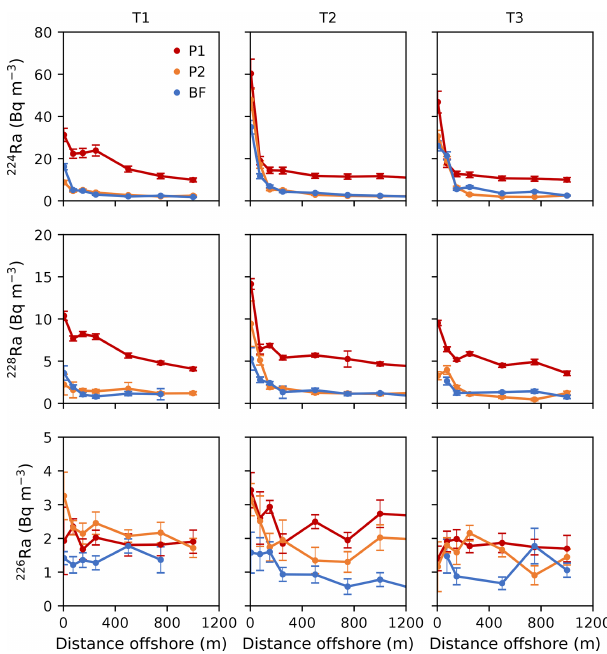
Figure 3. Radium isotopes activities ( 224 Ra, 228 Ra, and 226 Ra) in coastal seawater samples collected during the samplings per- formed in October 2019 (P1 and P2) and March 2020 (BF) for the three transects perpendicular to the coastline corresponding to the ephemeral streams of Argentona (T1), Cabrera de Mar (T2), and Vilassar de Mar